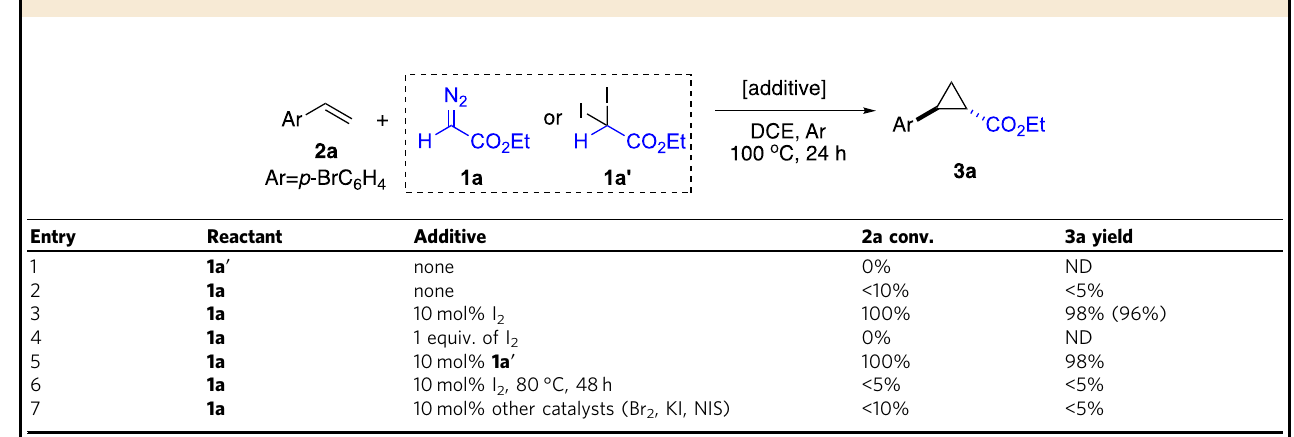
Table 3 Optimization of the reaction conditions under thermal-initiation conditions